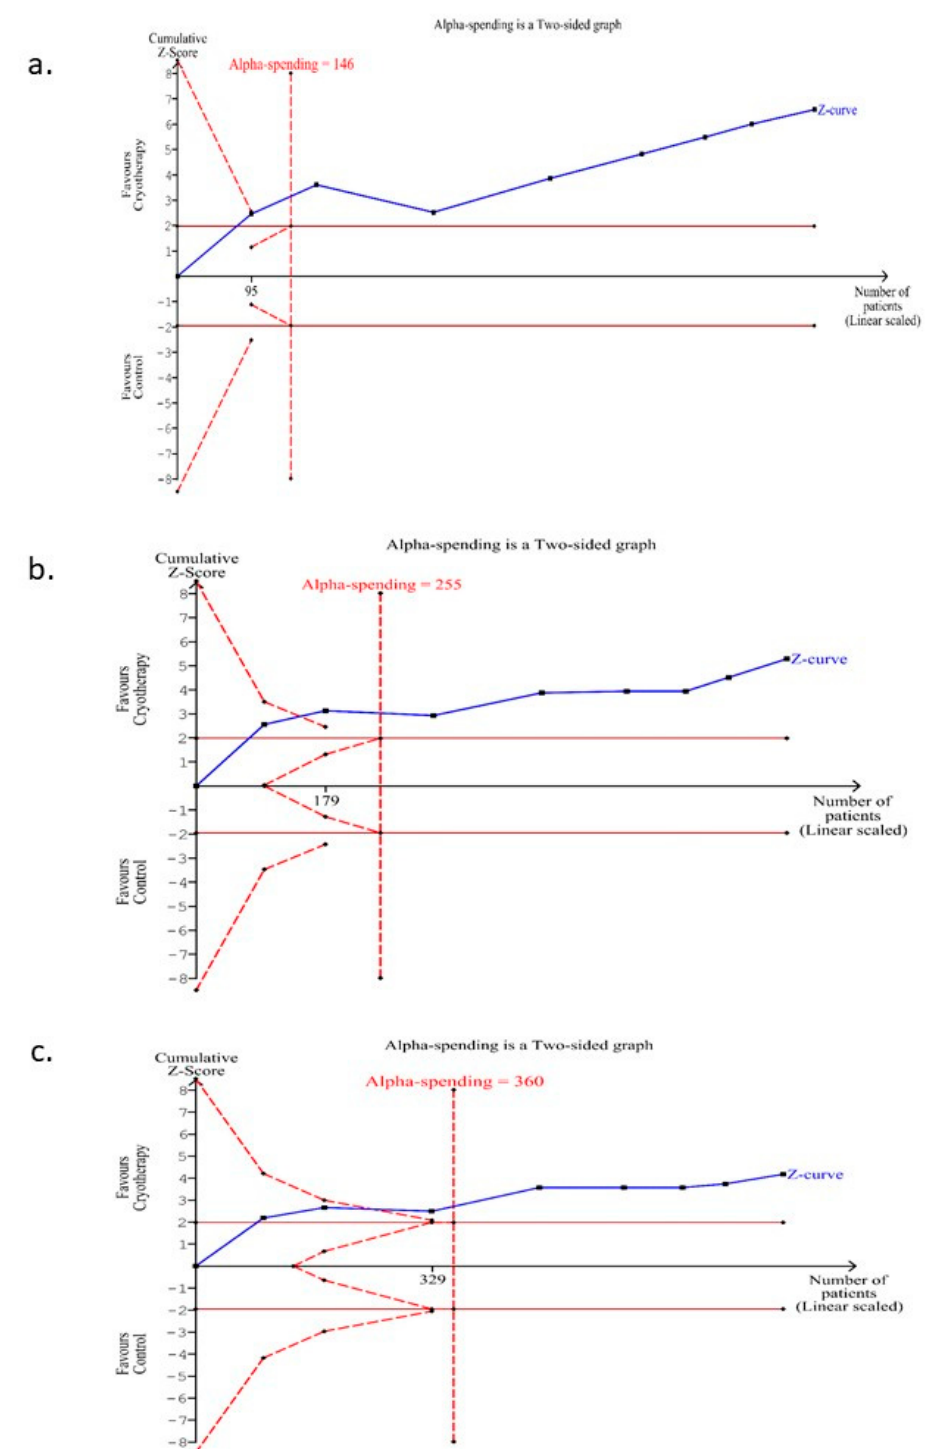
Figure 5. Trial sequential analysis for the OC for solid malignancies subgroup for ( a ) any grade, ( b ) moderate-severe grade and ( c ) severe grade.